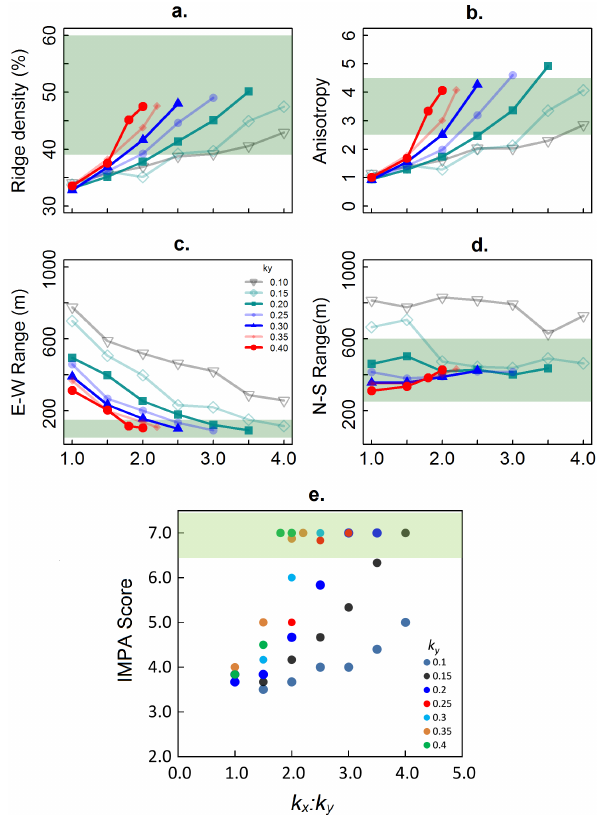
Figure 6. Mean values of statistical and geostatistical metrics in simulated landscapes (symbols) relative to the ranges observed in reference landscapes (shaded regions): (a) ridge density (% R ), (c) patch anisotropy ( e) , (c) semivariogram ranges in the E–W di- rection (perpendicular to flow), (d) semivariogram ranges in the N– S direction (parallel to flow), and (d) average (IMPA) scores for all kx : ky